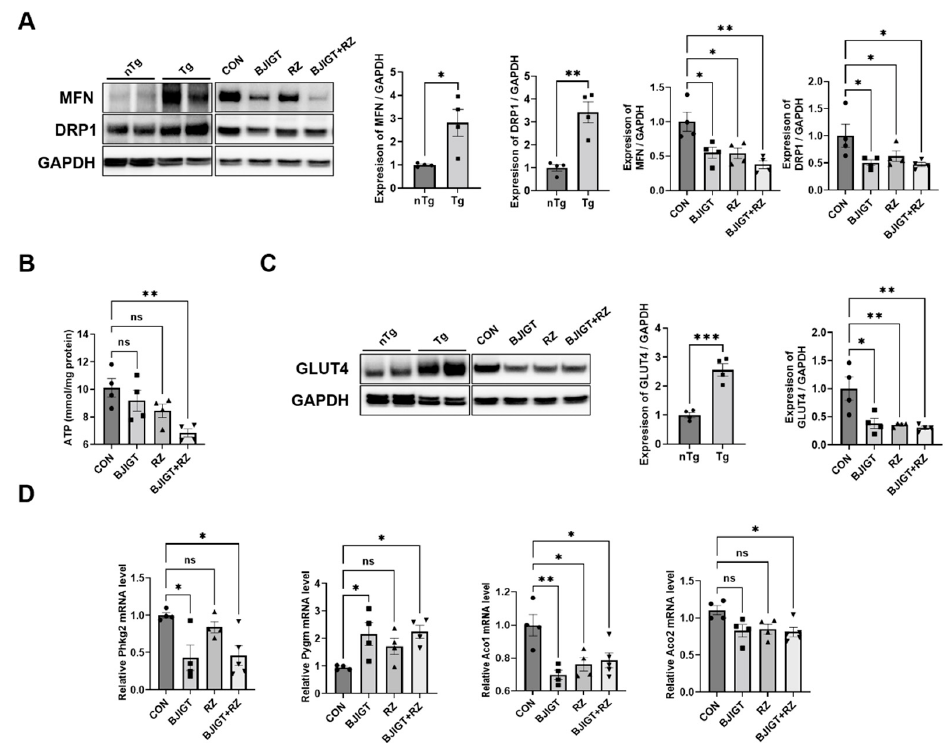
Figure 3. Combined BJIGT/RZ treatment ameliorates mitochondrial dysfunction in the GC of the hSOD1 G93A ALS mouse model. ( A ) Representative Western blots depicting the alteration in mito- chondrial dynamic-related proteins including mitofusin (MFN) and dynamin-related protein (DRP1), in the GC of the control, BJIGT, RZ, and combined BJIGT/RZ treatment groups of hSOD1 G93A mice. GAPDH was used as a loading control to normalize the protein levels. Quantification of bands showing the levels of MFN and DRP1 in the drug treatment groups compared with those in the control group ( n = 4/group). ( B ) Quantitative analysis of the ATP levels in the GC of each group of hSOD1 G93A mice ( n = 4/group). ( C ) Representative Western blots and quantification of the bands pertaining to glucose transporter type 4 (GLUT4) in the GC of each group of hSOD1 G93A mice. Glyceraldehyde-3-phosphate dehydrogenase (GAPDH) was used as the loading control. ( D ) Quantitative analysis of the relative mRNA expression of enzymes involved in glycogenolysis and tricarboxylic acid (TCA) cycle, including phosphorylase kinase ( Phkg2 ), glycogen phosphorylase ( Pygm ), and aconitases ( Aco1 and Aco2 ), in the GC of each group of hSOD1 G93A mice ( n = 4–5/group). Data are normalized to the control group data and presented as mean SEM. ns: not significant, ± * p < 0.05, ** p < 0.01, and *** p < 0.001, compared with the control group, DW-administered transgenic (Tg) mice (CON), BJIGT-treated Tg mice (BJIGT), RZ-treated Tg mice (RZ), and com- bined BJIGT/ RZ-treated Tg mice (BJIGT+RZ). The different number of circles, squares, and triangles are indicated the number of sample